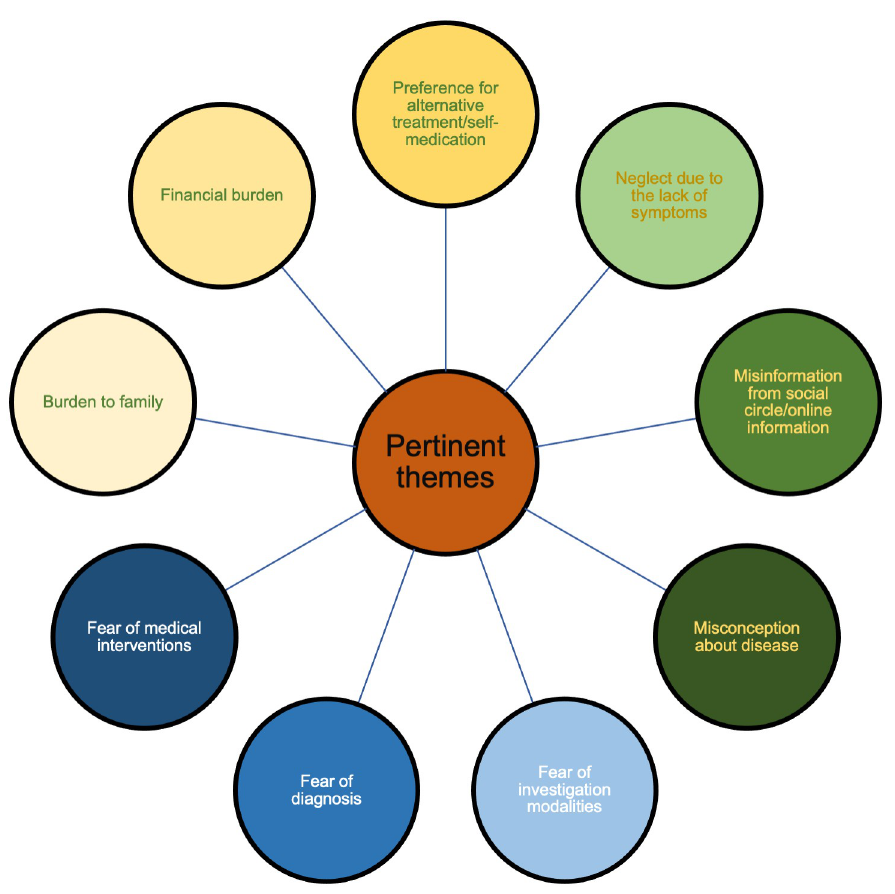
Fig 1. Pertinent themes elucidated from the